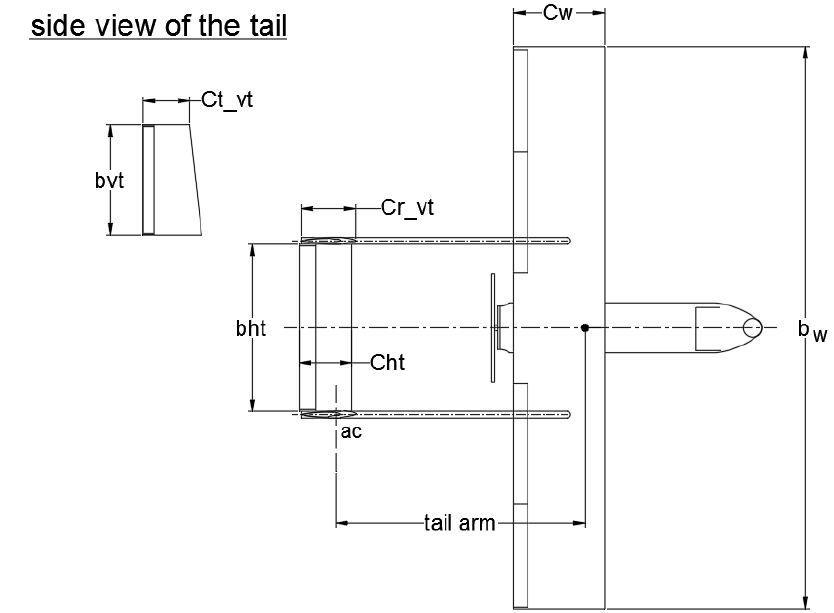
Figure 7. Definition of design variables for Aegis UAV with the U-tail shape.